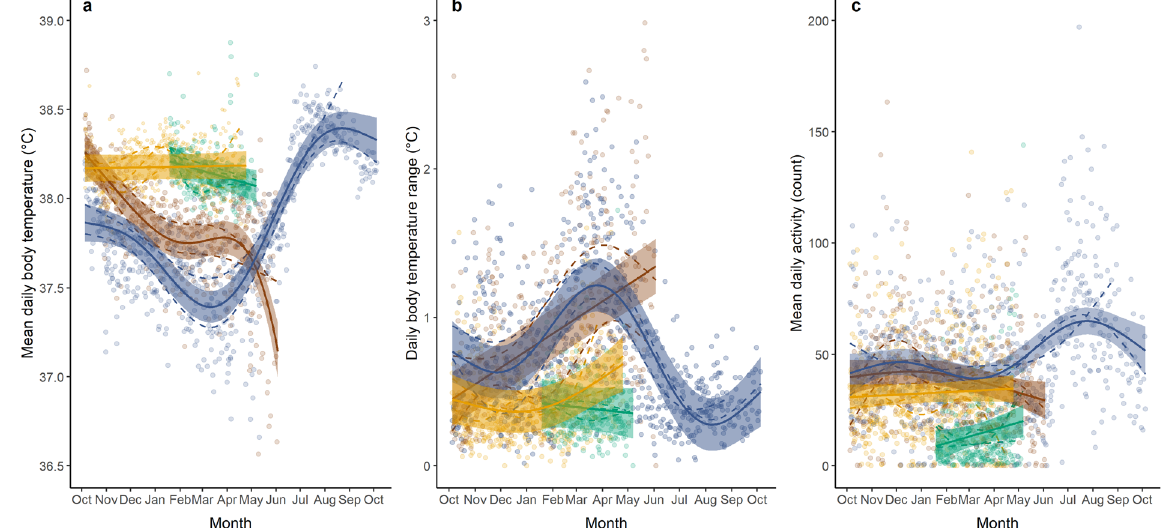
Figure 2. Body temperature and activity profiles of female muskoxen from October 2017 to October 2018. Colours indicate female muskoxen that survived and gave birth in the wild (orange; n = 3) or in captivity (green; n = 3), survived but did not reproduce (blue; n = 2), or died during winter (brown; n = 2): ( a ) mean daily core body temperature (°C), ( b ) daily body temperature range (°C), and ( c ) mean daily activity (count). Dots indicate the individual daily values, dashed lines are the smoothed curves for each muskox individual, while full lines show the predicted curves for each group and the corresponding 95% confidence intervals from the Generalized additive mixed